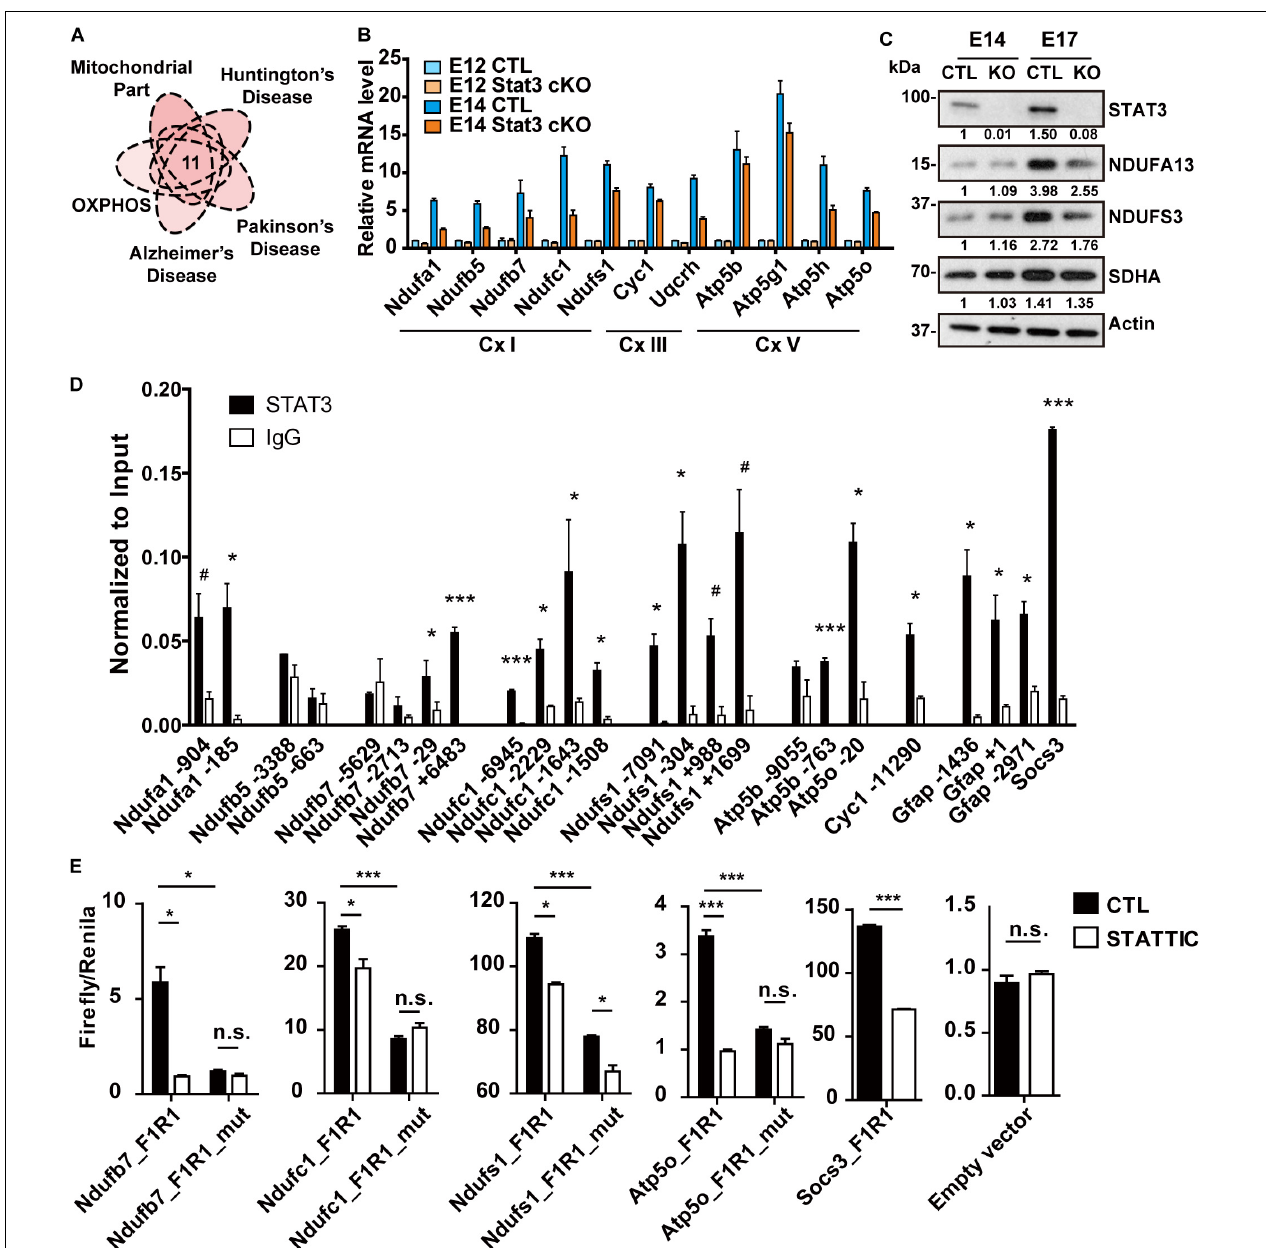
FIGURE 3 | STAT3 promotes the expression of OXPHOS genes in neural progenitors. (A) One group of potential STAT3 targets was involved in the mitochondrial oxidative phosphorylation as well as the neurodegenerative diseases. (B) RT-qPCR confirmed the expression of these genes was upregulated during neural progenitor development and downregulated in Stat3 cKO. (C) Western blot showed that the expression of complex I proteins was downregulated in Stat3 cKO neural progenitors isolated at E17. (D) ChIP-qPCR showed that STAT3 directed bind to the promoter or enhancer of the OXPHOS genes such as Ndufa1 , Ndufb7 , Ndufc1 , Ndufs1 , Atp5b , Atp5o . (E) Dual luciferase reporter assay showed that STAT3 binds to the promoter of OXPHOS genes and activate their transcription. Treatment of STATTIC or mutation of the STAT3 binding site downregulated the reporter activity. Socs3 promoter was used as the positive control, while the empty reporter vector was used as the negative control. # p < 0.08, * p < 0.05, ** p < 0.01, *** p < 0.005, n.s. not significant. Error bars represent mean ± standard